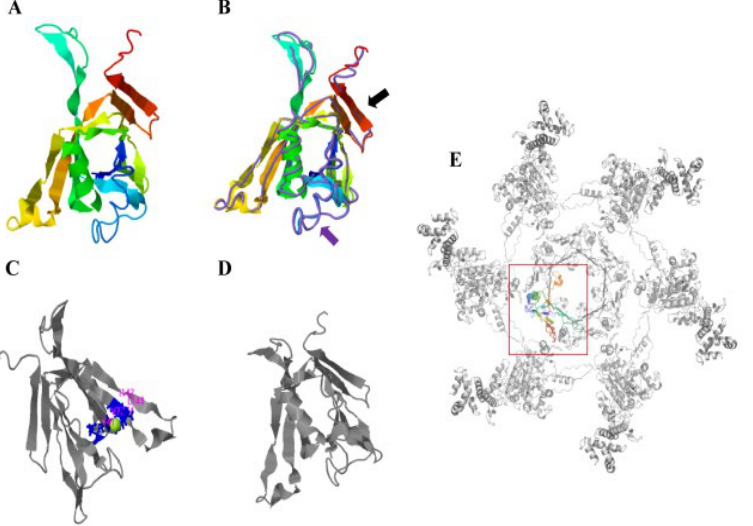
Figure 2. Protein structure prediction of hcp gene of A. salmonicida . ( A ) Protein structure diagram of Hcp predicted by I-TASSER. ( B ) The crystal structure comparison between the Hcp domain (indicated by the black arrow) of A. salmonicida and the original Hcp (PDB ID: 5mxn1) template (indicated by the purple arrow). ( C ) The prediction of ligand-binding sites (ligand-binding residues were V41, T71, V72, L141, and I142). ( D ) Active site map. ( E ) The location distribution of PDB-predicted protein model of Hcp in type-VI secretion system (top view of one ring of Hcp with associated VipA/VipB;